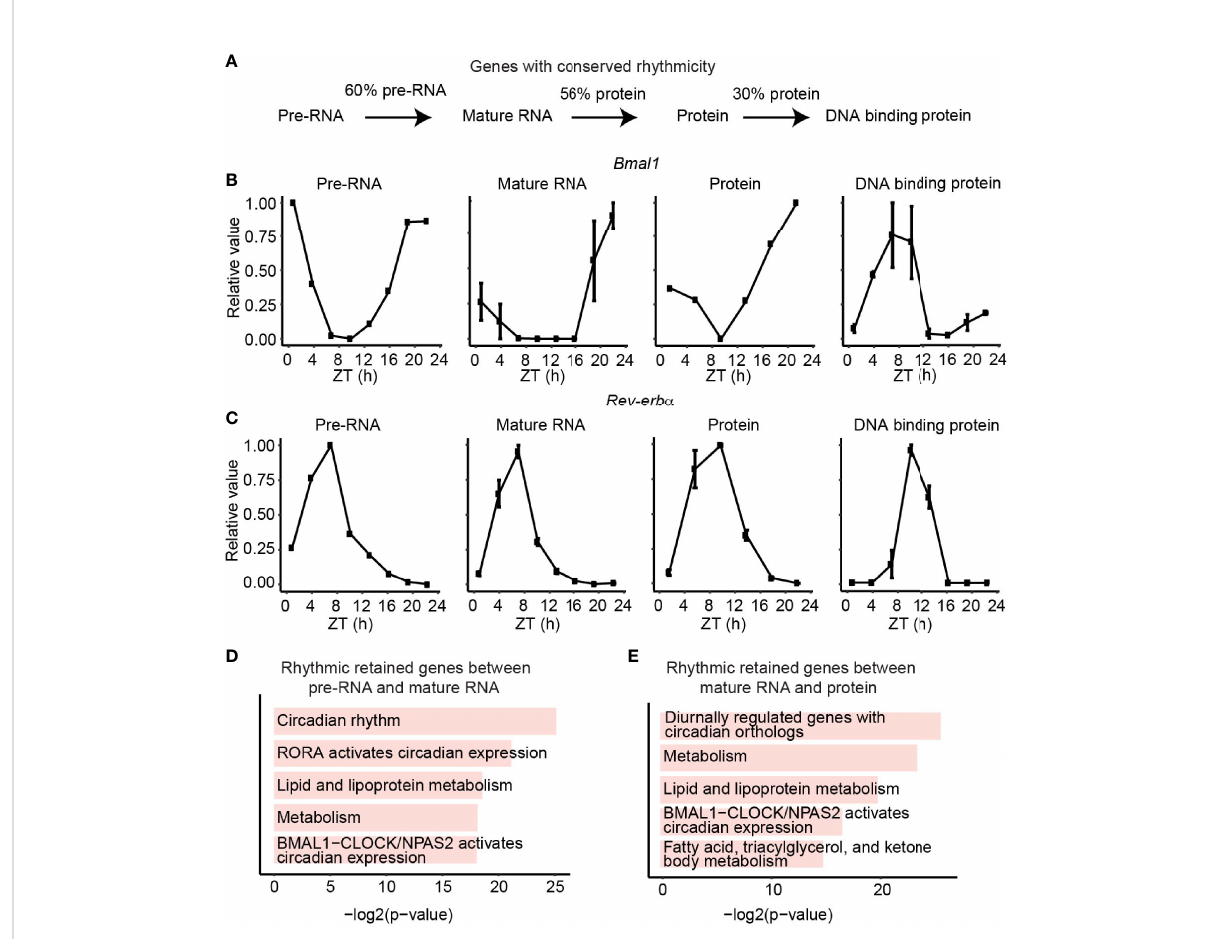
FIGURE 3 Rhythmic retained genes between adjacent layers. (A) The fraction of conserved rhythmic genes between adjacent layers. (B, C) The expression/ activity of conserved rhythmic gene Bmal1 (B) and Rev-verb a (C) at transcription, mature RNA, protein, and DBP level. (D, E) Bar plots show the enriched pathways of conserved rhythmic genes between transcription and mature RNA levels (D) , and the conserved rhythmic genes between mature RNA and protein levels (E) . Only genes detected in both adjacent layers were